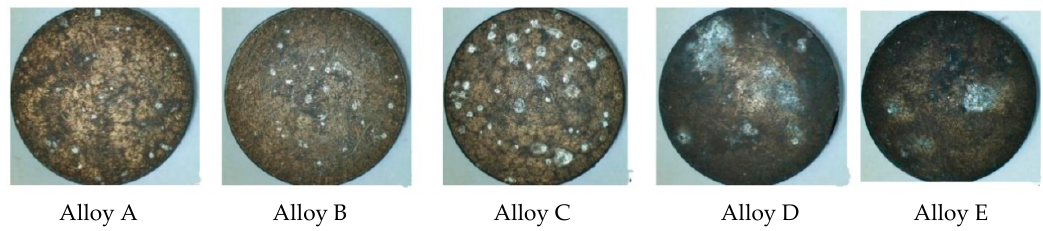
Figure 4. Corrosion characteristics of the tested alloys after exposure test.